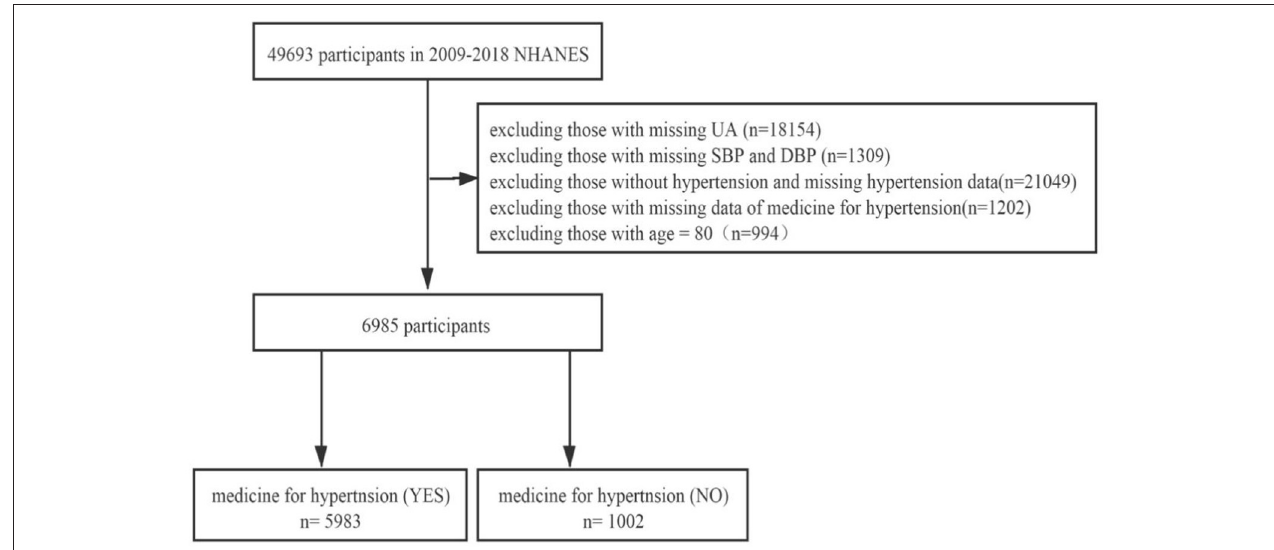
FIGURE 1 | Flowchart of the study design and participants excluded from the study. UA, uric acid; SBP, systolic blood pressure; DBP, diastolic blood